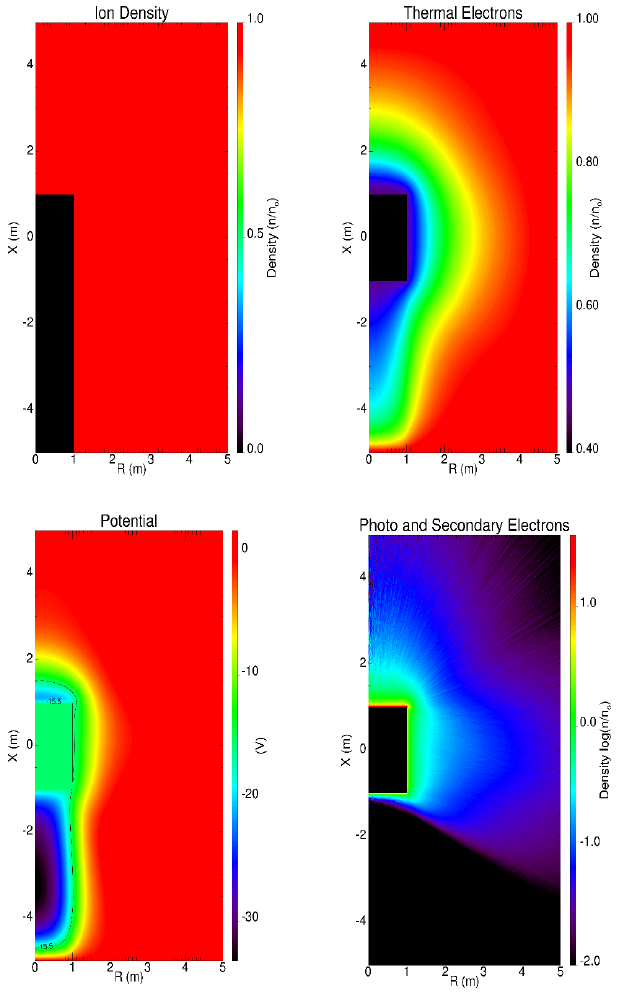
Fig. 3. Cross comparison simulation A. From the upper left to the bottom right of the picture: Ion density; Thermal electron density; SC potential. Photoelectron and SEE densities. n 0 is the plasma density: 7.10 9 m − 3 .